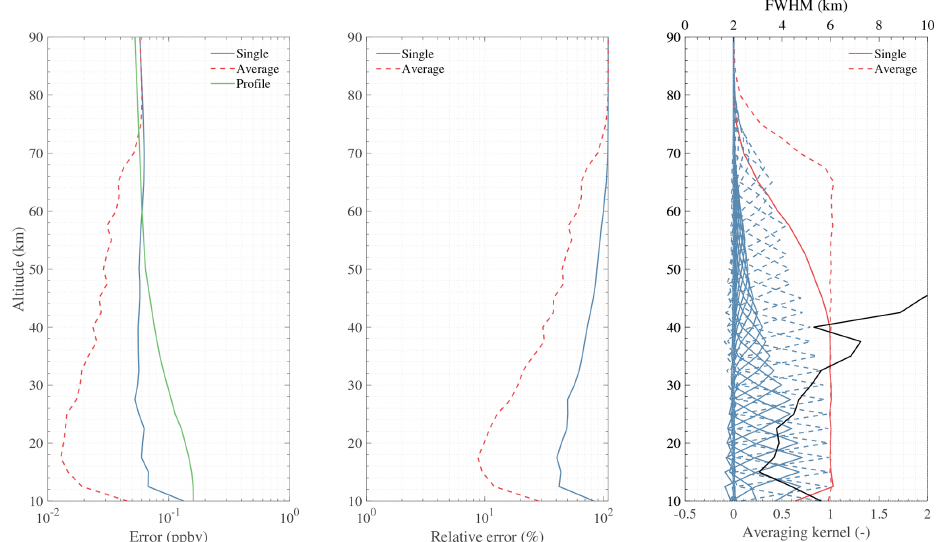
Figure 20. Simulation result of HCN retrieval using 177.26GHz lines. “Single” and “Average” represent the retrieval error using different noise. “Profile” represents the typical profile used in the simulation. The black solid line in the last panel represents the FWHM (i.e. vertical resolution).